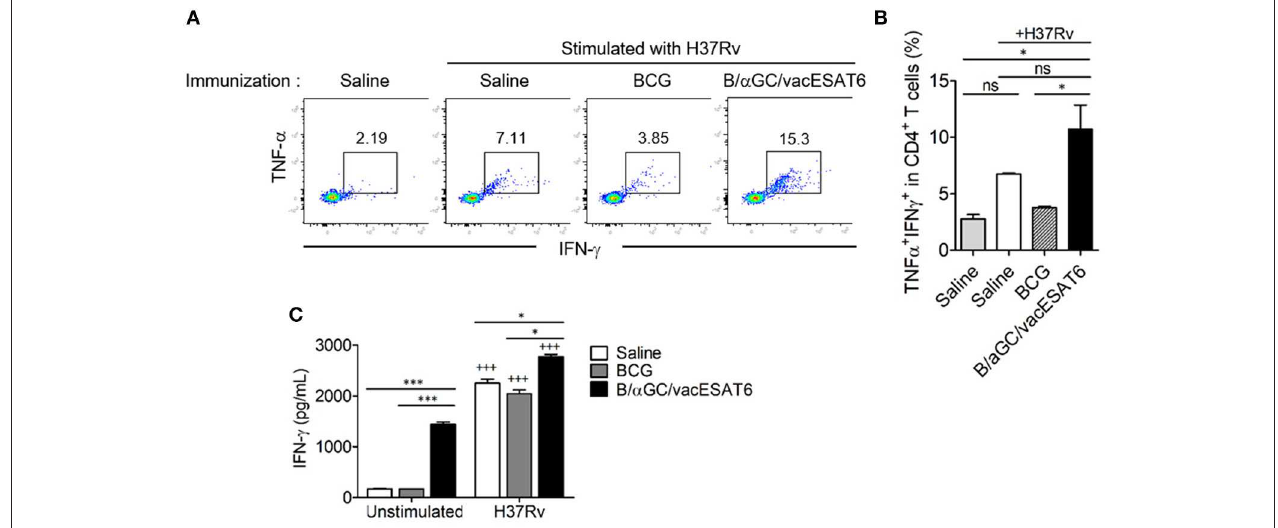
FIGURE 2 | B/ α GC/vacESAT6 induced M. tuberculosis specific CD4 + T cell response. Splenic CD4 + T cells were isolated from mice which were immunized with BCG (10 5 CFU/mouse) or with B/ α GC/vacESAT6 (Bvac), and they were co-cultured with CD11c + dendritic cells which were stimulated with heat-killed M. tuberculosis H37Rv at 0.1 MOI. After 72h co-culture, CD4 + T cells were analyzed by flow cytometry to detect intracellular TNF- α and IFN- γ production. (A) Representative intracellular staining of TNF- α and IFN- γ . (B) Summary of TNF- α and IFN- γ secreting CD4 + T cells. (C) Secreted IFN- γ levels were measured